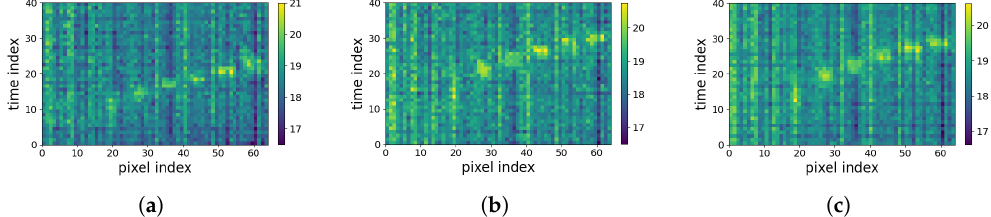
Figure 17. Illustration of the 2D spatiotemporal maps of subject 1 performing activity “Walking- Diagonally 1”: ( a ) repeat 1; ( b ) repeat 2; ( c ) the artificially generated 2D map using the ( a , b )